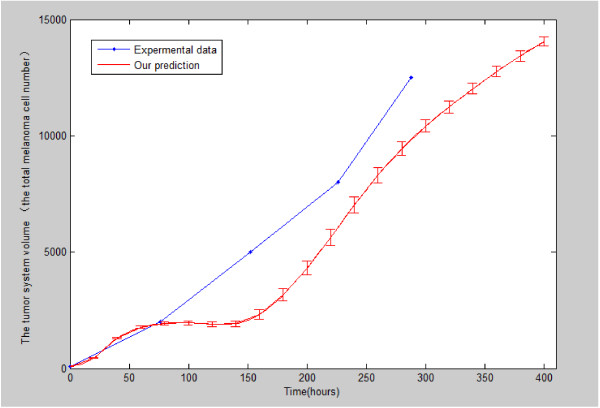
The tumor system volume (y-axis) over time (x-axis) derived from simulations (red line, for t = 0-400 hours) and fromin vitroexperimental observations (blue line, for t = 0-300 hours).